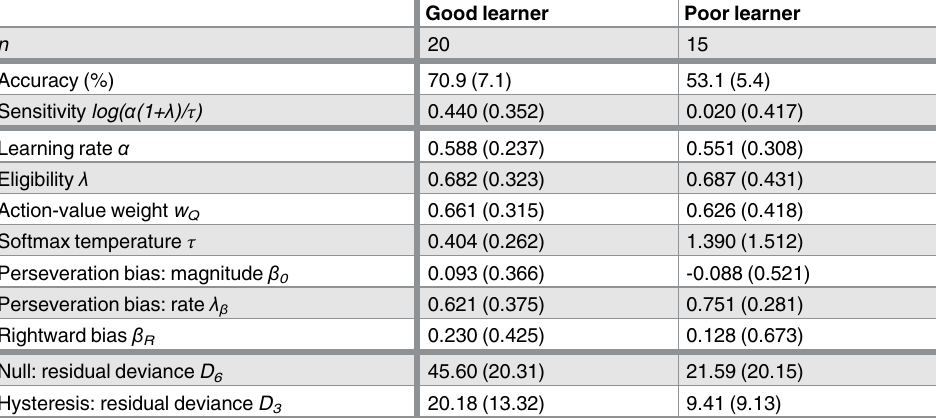
Table 2. Model parameters. The meansand standard deviationsof the ACQ model’s fitted parameters— includingfrom the hysteresis modelthe (arbitrarily rightward)constant choicebias β R andinitialmagnitude β 0 coupledwith inversedecay rate λ β for exponential decay of the perseveration bias—arelisted separatelyfor eachgroup, revealinga tendencyfor Good learnersto have lower temperature than Poor learners( M = 0.987, t 33 = 2.88, p = 0.004).The logarithmof the ratio betweenthe eligibility-adjustedlearningrate andthe tempera- ture providesa more precisemetric for the sensitivity dictatedby the model’sfitted parameters than the temper- ature alone—especiallygiventhe correlationbetween the eligibility-adjusted learning rate and the temperature [57]exhibited withinthe Poor-learner group( r = 0.547, t 13 = 2.36, p = 0.035) and the lack of such a correlation amongGood learners( r = 0.121, t 18 = 0.52, p = 0.611). Modelsensitivity, whichwas significantly positive across the Good-learner group ( M = 0.440, t 19 = 5.59, p < 10 -4 ) but not the Poor-learner group ( M = 0.020, t 14 = 0.18, p = 0.428), was not only greaterfor Good learnersthan for Poor learners( M = 0.420, t 33 = 3.23, p = 10 -3 ) but also significantlycorrelated with the objectivemetric for choiceaccuracy( r = 0.409, t 33 = 2.57, p =